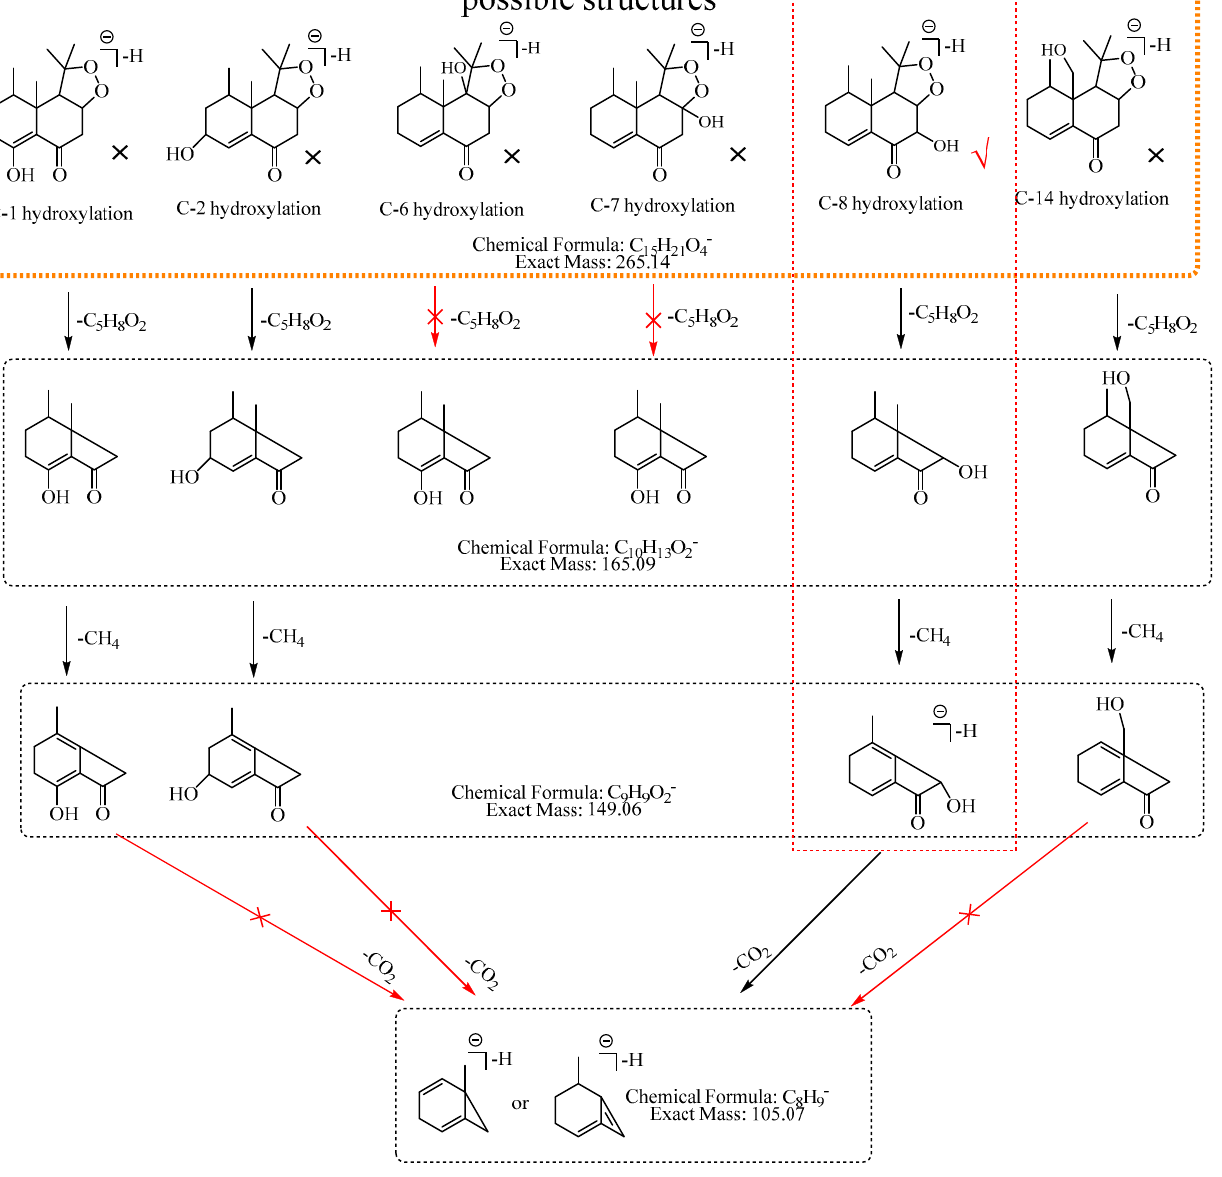
Figure 6. The proposed fragmentation pathways of M4 (8-hydroxyl nardosinone). “ √ ” represents the possible structure. “×” represents the impossible structure. The orange rim represents the possible structures. The red rim represents the most possible frag- mentation pathway.